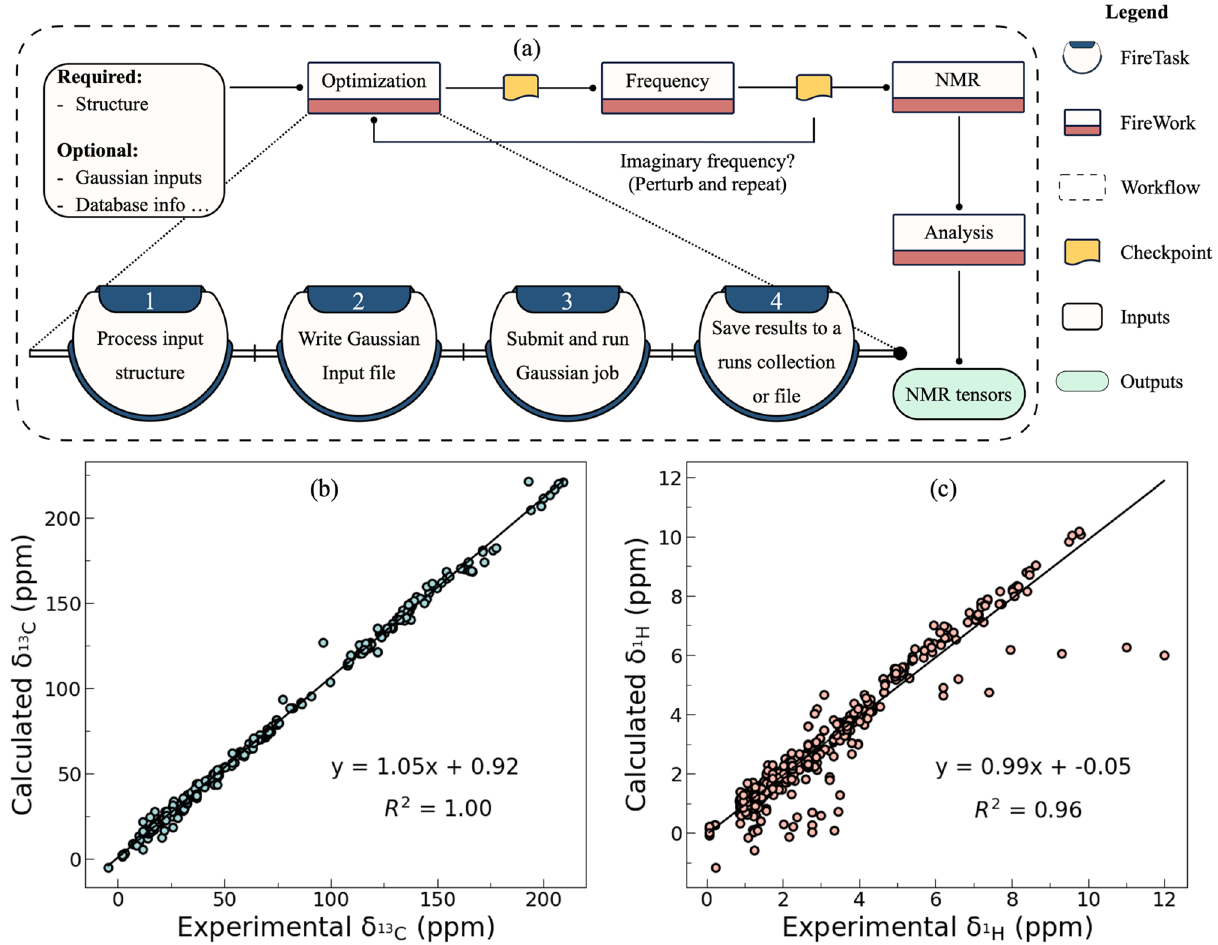
Figure 4. NMR workflow ( a ) diagram of the standard steps of the workflow that only requires the structure as input but the user can customize parameters and operations as needed, and linear regression of sample ( b ) 13 C and ( c ) 1 H chemical shifts obtained from the MISPR workflow versus experimental NMR chemical shifts. R 2 indicates the correlation